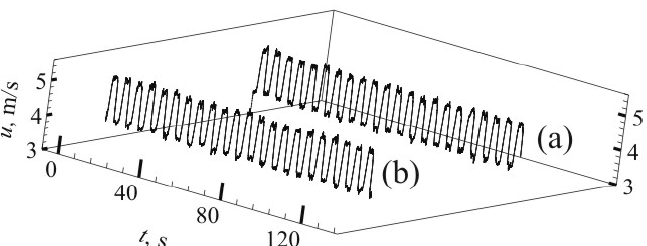
Figure 2. Example velocity time series in accordance with periodic features of the bora wind: ( a ) model A (without wheels) and ( b ) model B (with wheels).